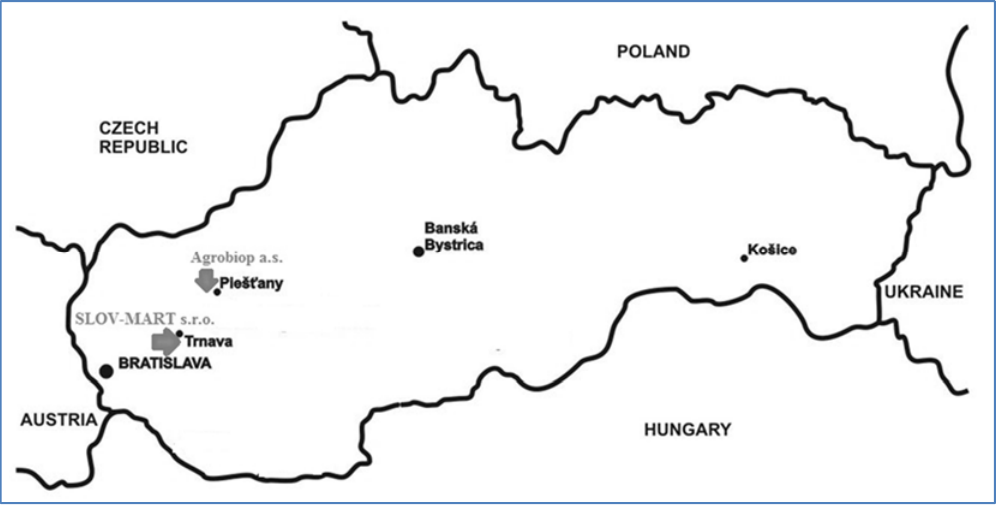
Figure 1. Location of measurement plain on western region on Slovak Republic map.